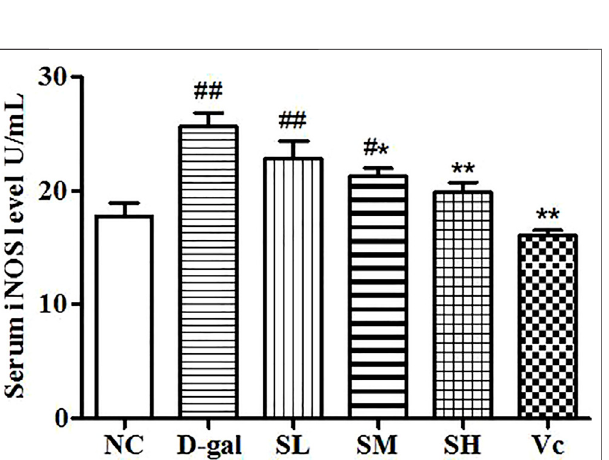
FIGURE4| ActivityofAChEinmicebrain.Comparedwithnormalgroup, #: p < 0.05; Compared with D – gal group, *: p < 0.05. NC: normal control group; D – gal: D – gal model group; SL: low – dose SDE group; SM: medium – dose SDE group; SL: high – dose SDE group; Vc: Vc positive control